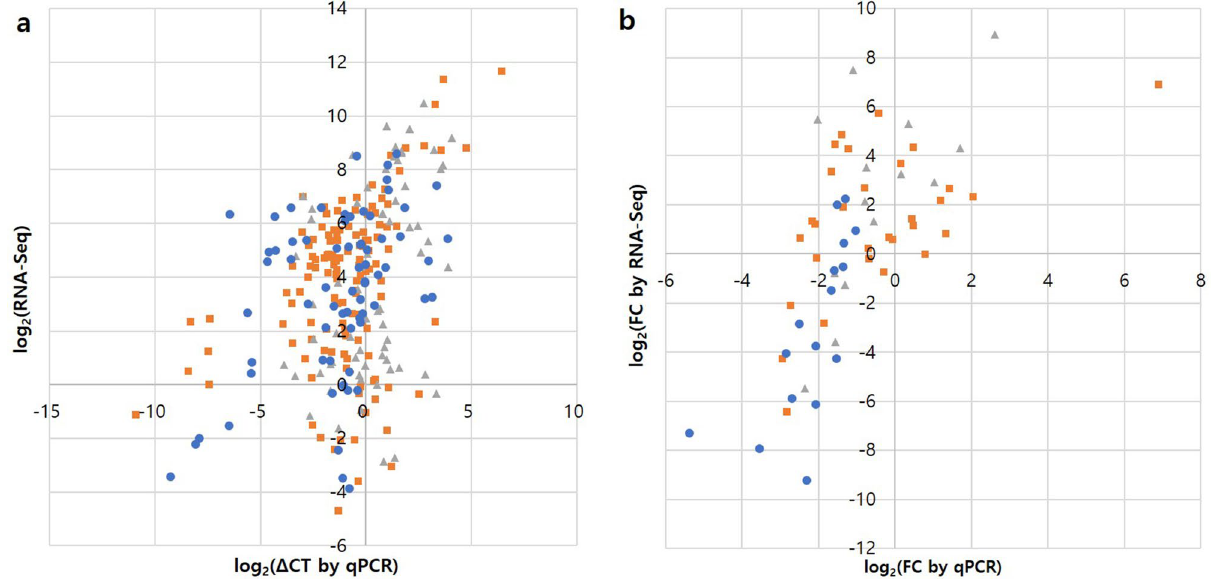
Figure 7. Comparison of expression profile by RNA-Seq and qRT-PCR. ( a ) Comparison between the log 2 of qPCR ΔCT values and RNA-Seq values for every biological replicate. ( b ) Comparison between the log 2 of gene expression ratios (versus control) from RNA-Seq data and qPCR data. Orange square, SE signaling genes; gray triangle, SE up-regulated genes; blue circle, SE down-regulated